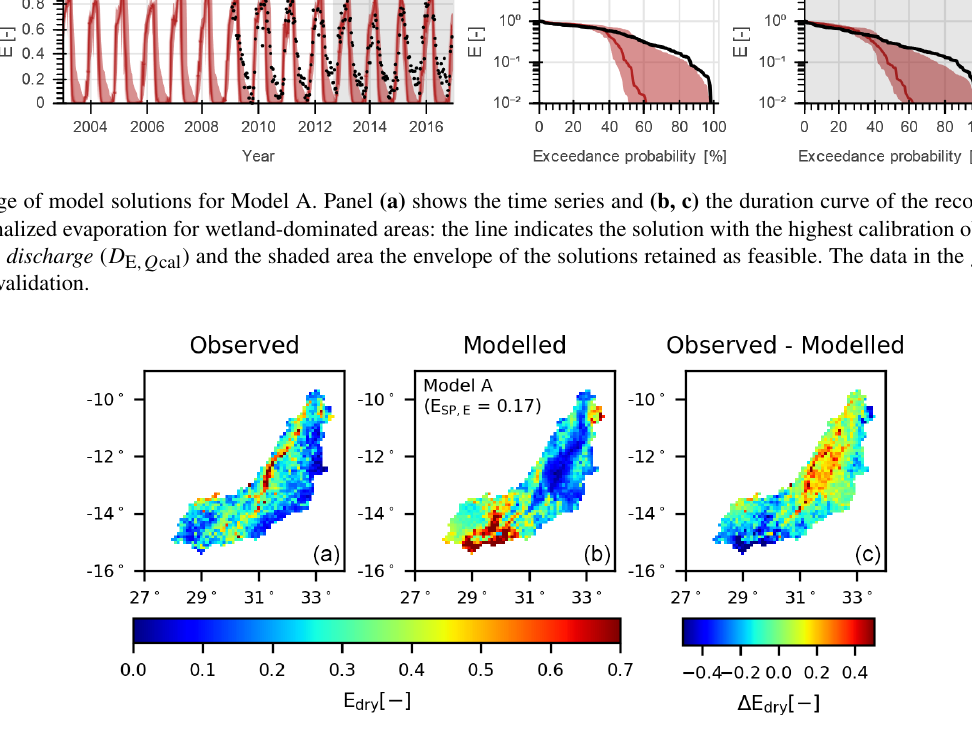
Figure 6. Spatial variability of the normalized total evaporation for Model A averaged over all days within the dry season. Panel (a) shows the observation according to WaPOR data, (b) the model result using the “optimal” parameter set with respect to discharge ( D E ,Q cal ) and (c) the difference between the observation and model.